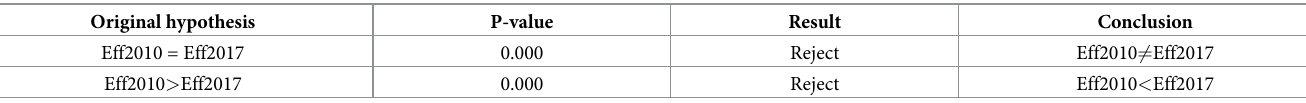
Table 4. T-test results on the average efficiency of herders’ breeding in 2010 and